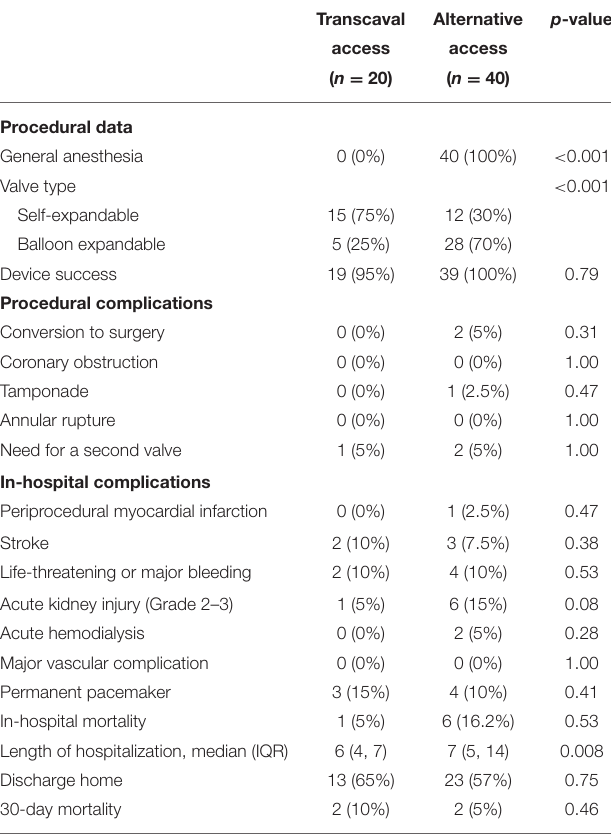
TABLE 3 | Propensity score matched procedural characteristics and outcome of patients undergoing TAVR via the transcaval vs. alternative